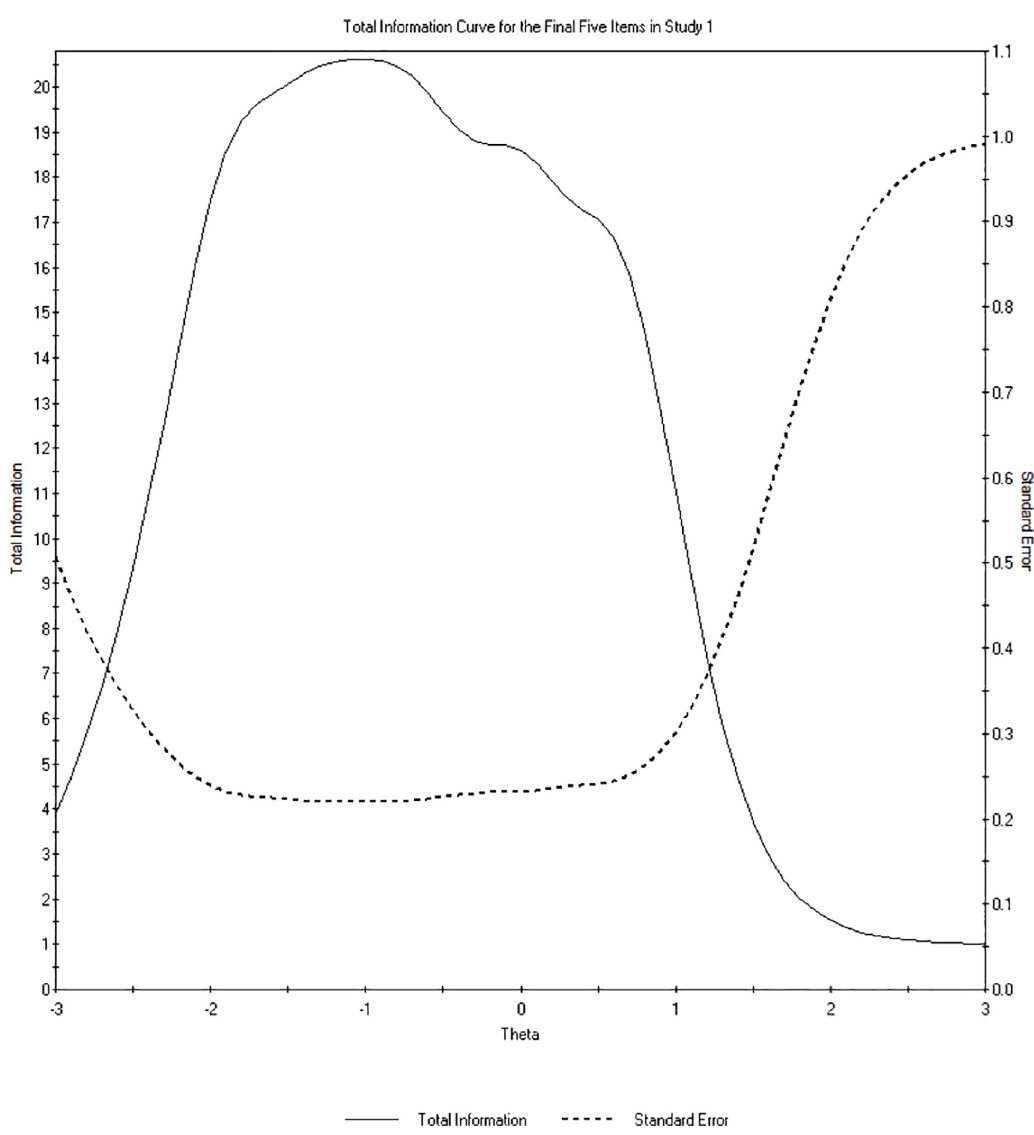
Fig 2. Total information curve for the final five-item scale in Study 1. The SEIS demonstrates high reliability for individuals between -2 and 1 on latent support for economic inequality, θ .